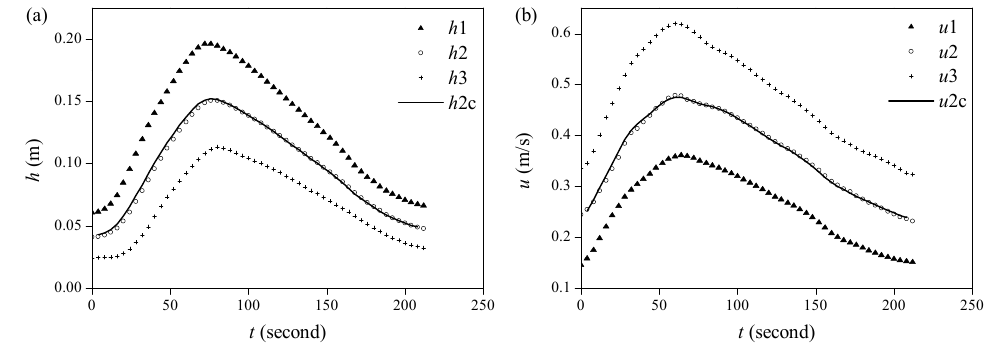
Figure 4. Evolution of hydraulic parameters at the 1st Section ( h 1, u 1), 2nd Section ( h 2, u 2), 3rd Section ( h 3, u 3), and the evaluated flow depth of nominal point M ( h 2c, u 2c) in Mode 9, Exp. 2. ( a ) flow depth; ( b ) mean cross-sectional velocity.